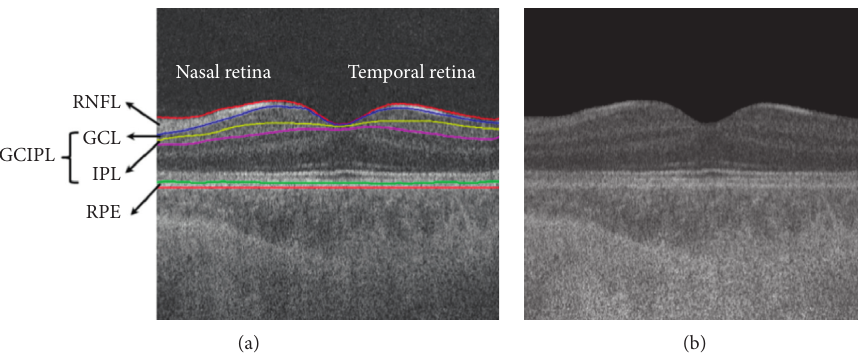
Figure 1: In vivo retinal scan of a normal subject. (a) Layer segmentation on the denoised and flattened image. (b) The attenuation coefficient image. RNFL: retinal nerve fiber layer; GCL: ganglion cell layer; IPL: inner plexiform layer; GCIPL: GCL combined with IPL; RPE: retinal pigment